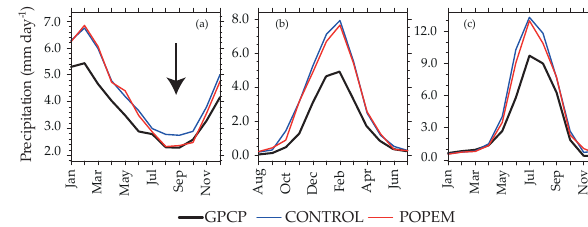
Figure 9. Monthly precipitation (1980-1999) based on GPCP, CONTROL, and POPEM for three of the regions with important bi- ases in CESM. (a) Shows precipitation for the area affected by the double-ITCZ bias in the Southern Hemisphere (20 ◦ S–0 , 80 ◦ E– 100 ◦ W); (b) for the top end of Australia (30–10 ◦ S, 128–140 ◦ E); and (c) for the Tibetan Plateau (22–32 ◦ N, 78–92 ◦ W). The black line represents observations (GPCP), the blue line is the CONTROL case, and the red line is the POPEM case. Units are in mmday − 1 . The arrow indicates the improvement of the POPEM model.